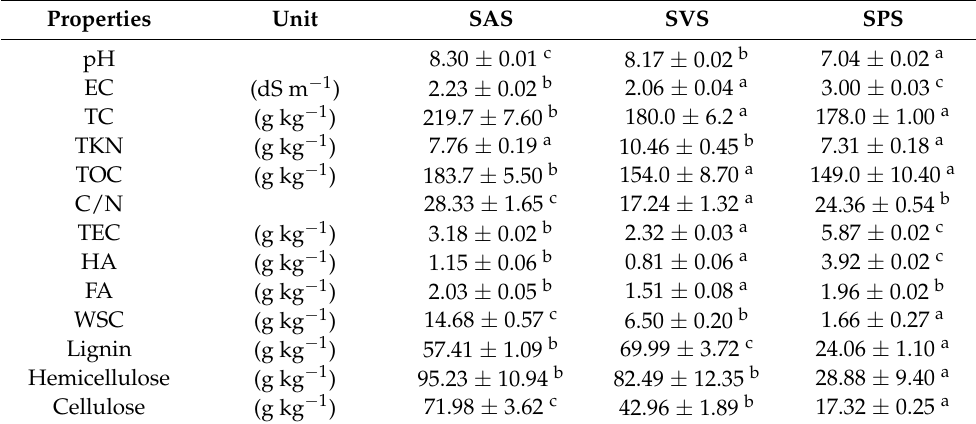
Table 1. Chemical properties (mean ± SD, n = 3) of the three assayed biomixtures: soil, wet olive cake or alperujo and barley straw (SAS), soil, vermicompost and barley straw (SVS) and soil, peat and barley straw